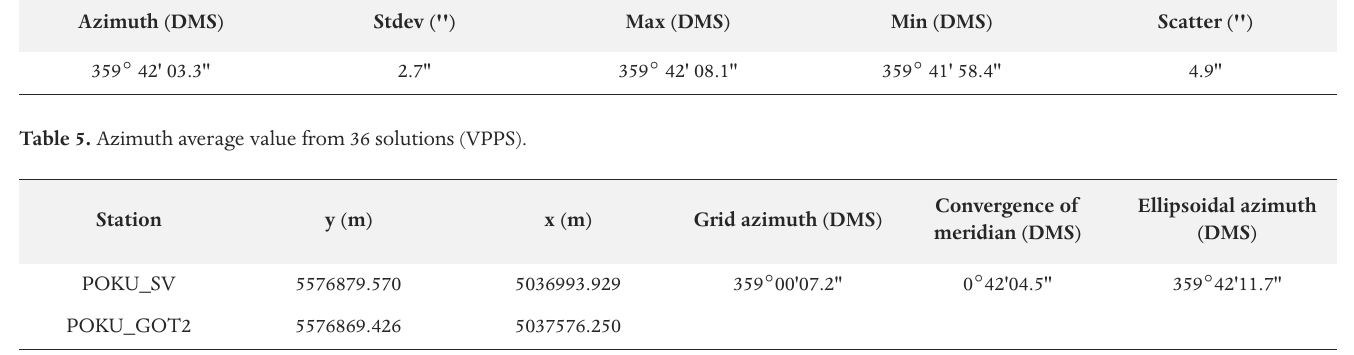
Table 6. Transverse Mercator plane coordinates computed from VPPS.